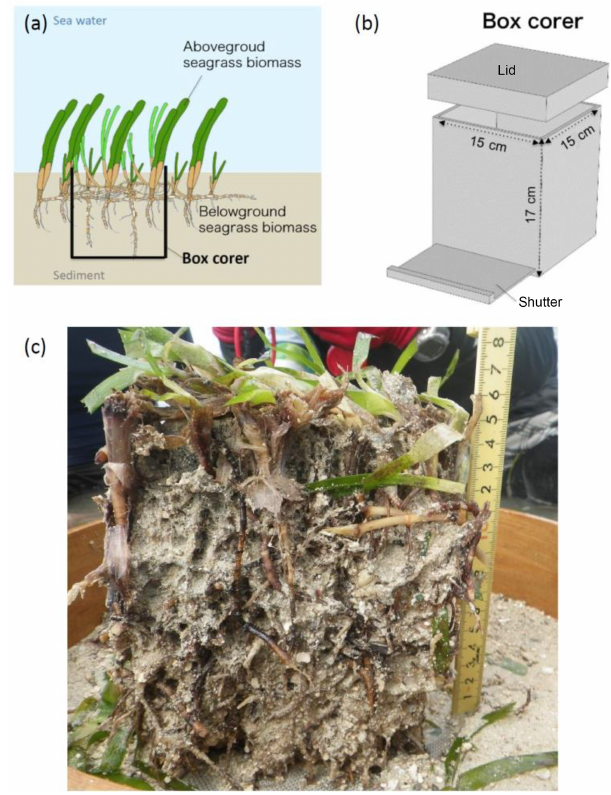
Figure 2. The newly developed box corer and a sampled core. Schematic diagrams of (a) a cross section of a core and (b) the de- sign of the corer. (c) Photograph of a core from the back-reef site. The dominant seagrass species is Thalassia hemprichii .